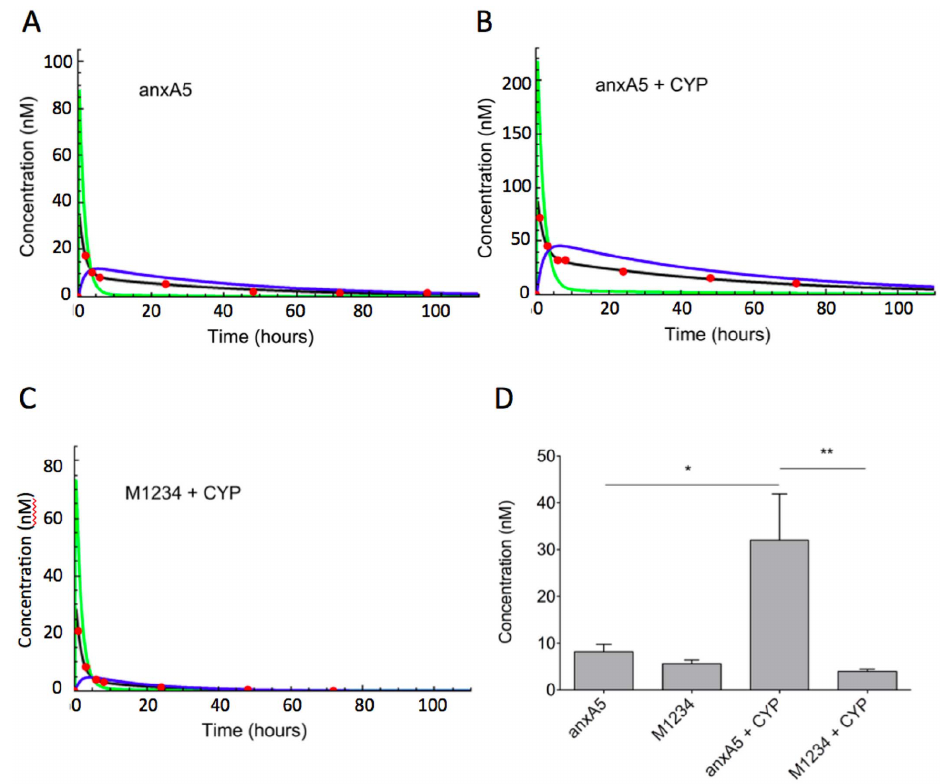
Figure 9. Computational compartmentalization of tumor uptake of anxA5 and M1234. The experimental data of Fig. 6B were fit according to the model of Fig. 8. Panels A–C show representative fits for anxA5 uptake by untreated (A) and cyclophosphamide treated tumor (B) and for M1234 uptake by cyclophosphamide treated tumor (C.) The experimental data (red circles) were used to calculate concentrations in whole tumor (black line), tumor interstitium (Comp. 2, red line) and bound to the PS-target (Comp. 3, blue line). Panel D shows the concentrations of anxA5 and M1234 in compartment 3 (PS-target) of tumor that was either untreated or treated with cyclophosphamide ( + CYP) 6 hours post-injection. *p , 0.05, **p , 0.01.